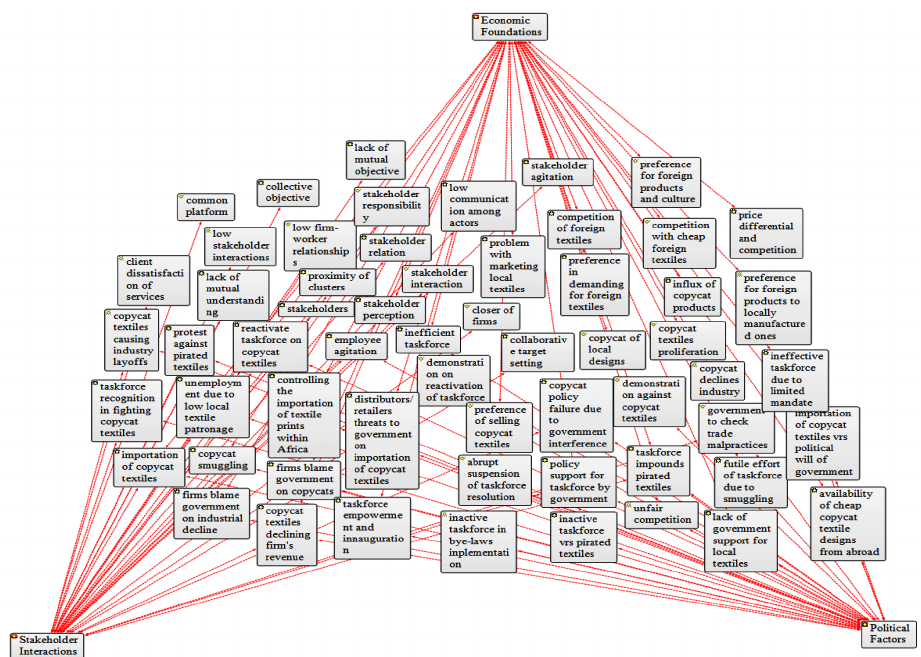
Figure 2. The network view of selective codes and their open codes (source: prepared by